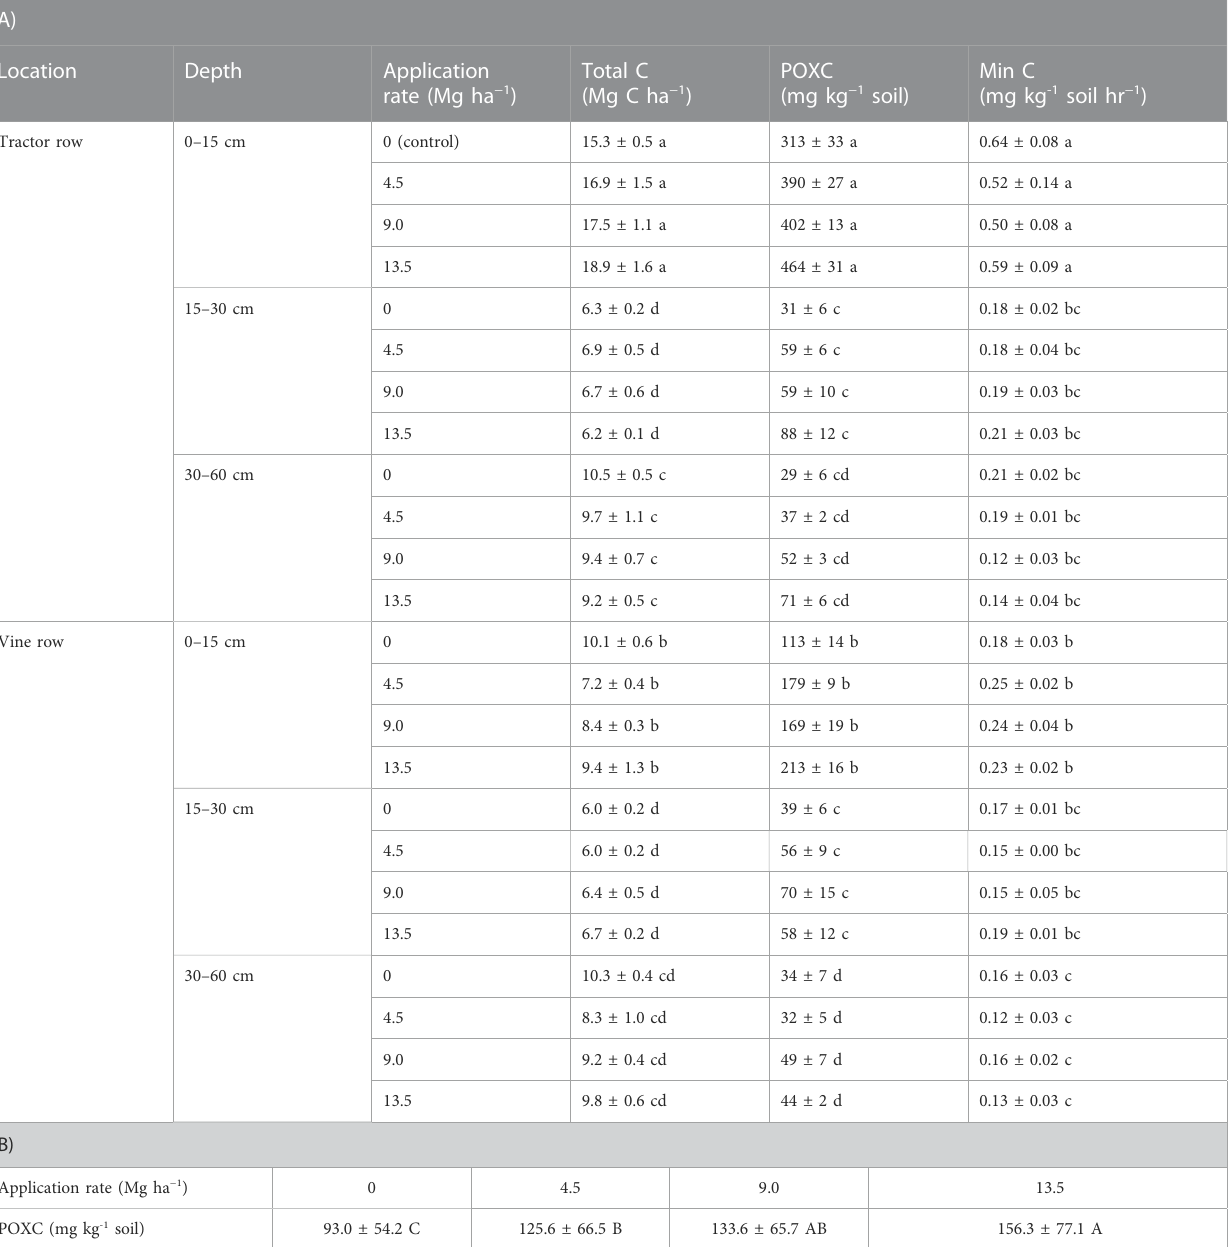
TABLE2A)TotalsoilC,POXCandMinC±standarderrorsofthemeans(n=4)asaffectedbycompostapplication rate,functionallocationanddepthinApril2020. Lowercase letters within the same column indicate signi fi cant interactive effects of location and depth at p < 0.05. B) Averages of POXC ± standard errors of the means (n = 4) by compost application rate in April 2020. Uppercase letters indicate signi fi cant main effect of the treatments at p <